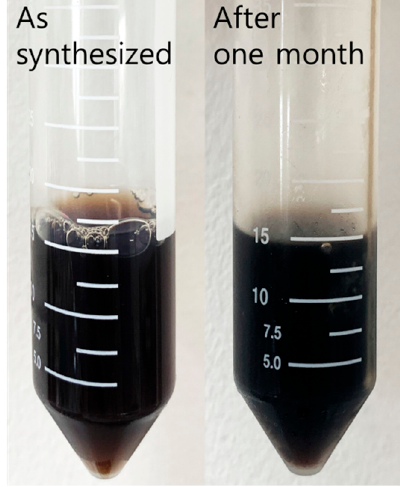
Figure 2. Image of cysteamine capped PbS quantum dot dispersed in water. (left) Image of quantum dot as synthesized, (right) Image of quantum dot one month after synthesis.